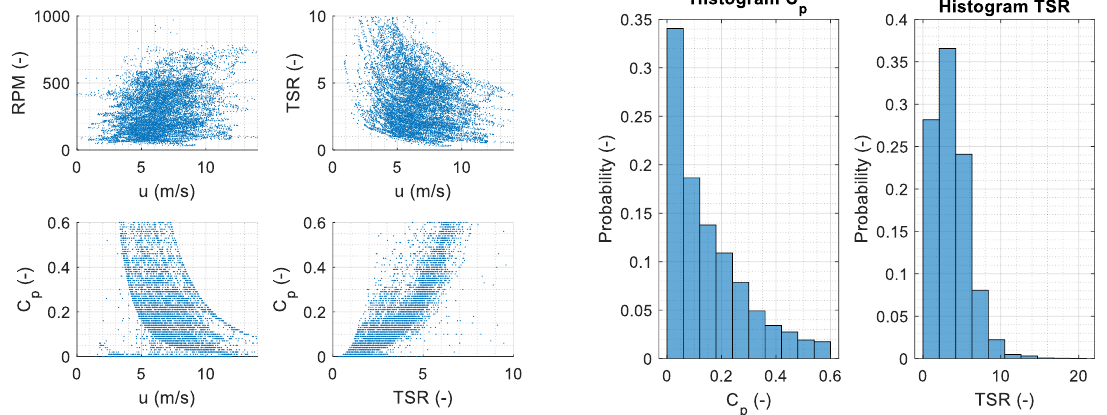
Figure 19. ( left 4 graphs) scatter plots of the 22-minute dataset for wind speed u(m/s), tip speed ratio, rotational speed (RPM), and coefficient of power performance C p ( right 2 graphs) histogram of probability of occurrence for the power performance coefficient c p and tip speed ratio (TSR).